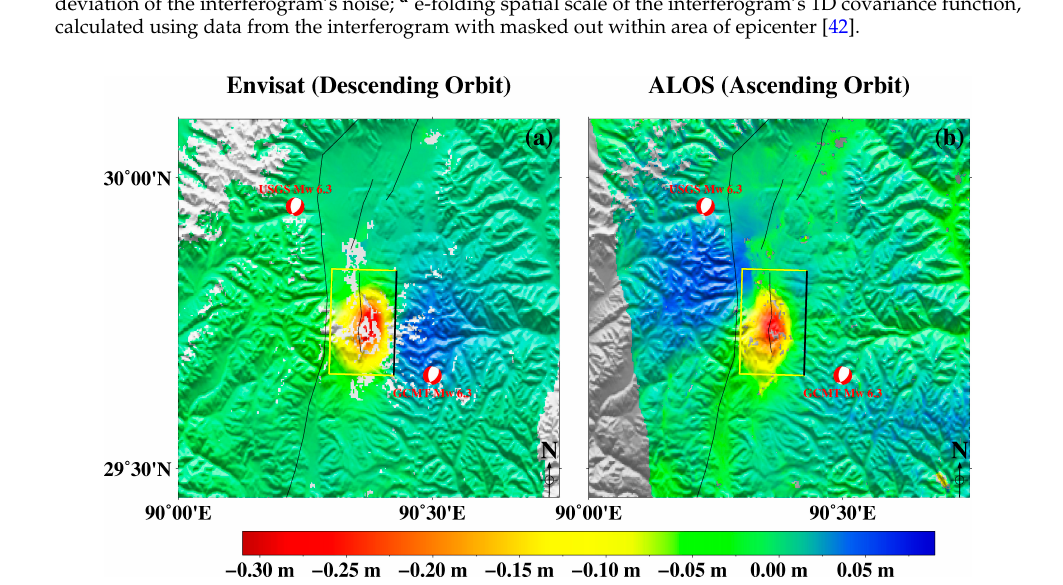
Figure 6 Figure 2. Coseismic deformation of the 6 October 2008 M W 6.3 Dangxiong earthquake along the